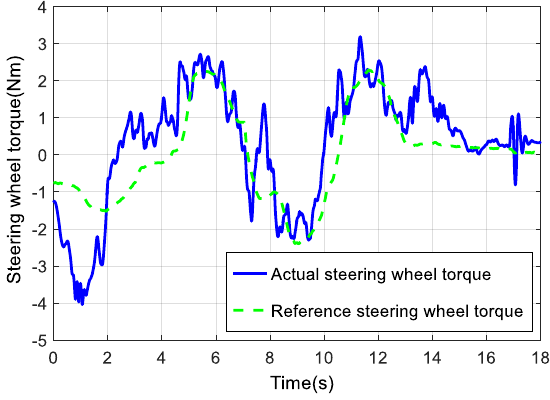
Figure 2. Steering wheel torque.